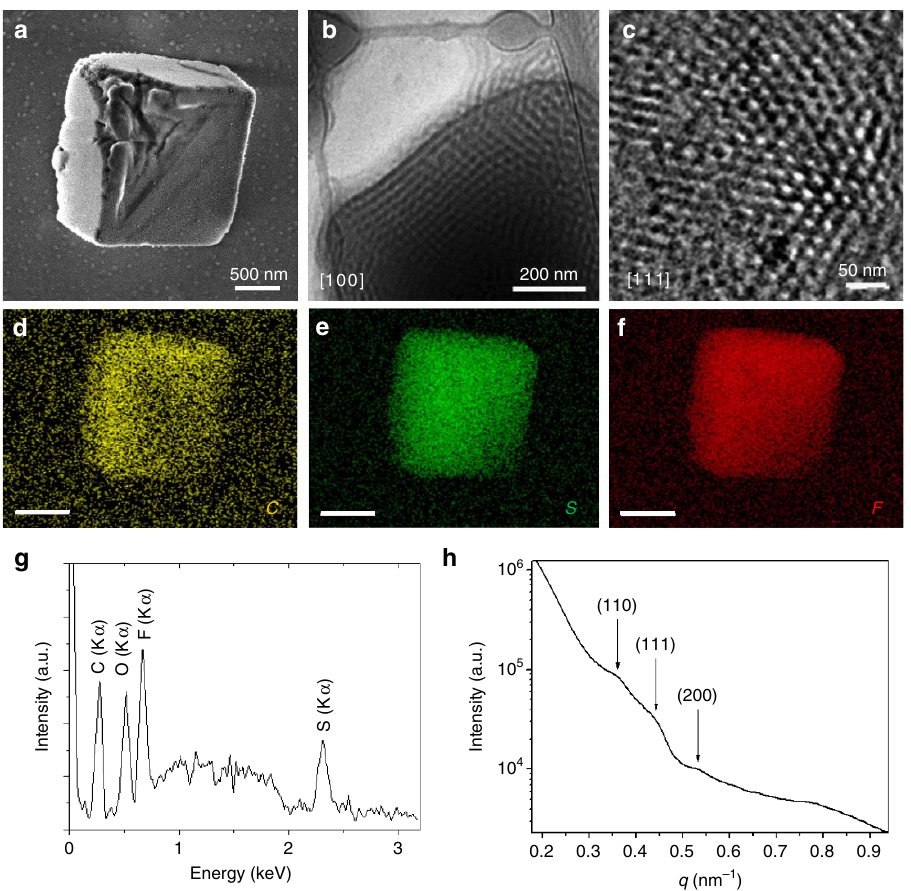
Figure 3 | Triply periodic structures of cubosomes. The electron micrographs of the self-assembled aggregates of PAA 45 - b -PIL 23 in water/THF solution recorded 2 days after adding water and aging the dispersion at 21 (cid:2) C. Self-assembling conditions: 2mgml (cid:2) 1 THF solution of PAA 45 - b -PIL 23 , water/THF volume ratio ( R) ¼ 1.6. ( a ) SEM micrograph of the dried cubosomes after dialysis. ( b ) Cryo-TEM image of the [100] facet of a cuboid particle. ( c ) Enlarged surface image recorded in the central area of a cuboid particle from the [111] facet. ( d – f ) Elemental mappings (scale bar: 100nm) show the uniform distribution of the elements C, S and F throughout the cuboid structure. The homogeneous distribution is in agreement with the interpenetrating bicontinuous structure expected for cubosomes. ( g ) Energy-dispersive X-ray spectrum. A Si peak was subtracted that originated from the silicon wafer on which the cubosomes were deposited. ( h ) SAXS diagram indicates a double diamond ( Pn 3 m ) lattice with a ¼ 23.5nm ( q / q * B ffiffiffi 2